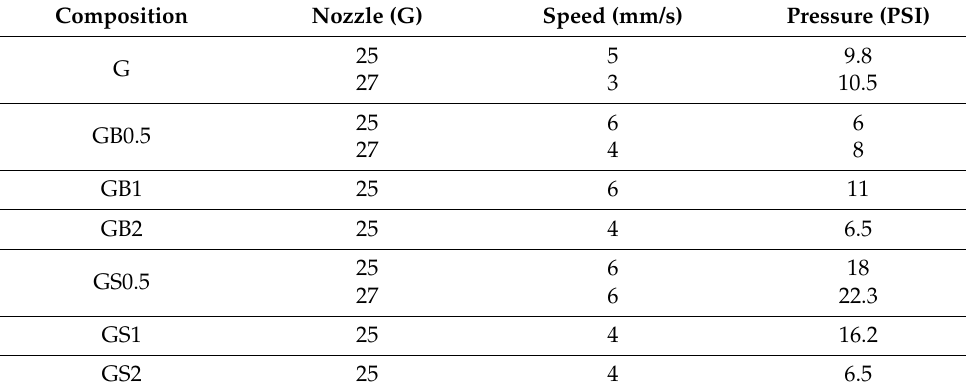
Table 2. Optimized printing parameters for each